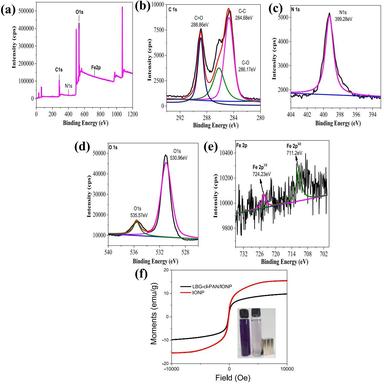
(a) An XPS spectrum of the composites with a wide scan; (b) XPS spectra of the C1s spectrum; (c) N1s spectrum; (d) O1s spectrum; and (e) Fe 2p spectrum of LBG-cl-PAN/IONP HNC. (f) LBG-cl-PAN-IONP measured by M-H hysteresis loop/vibrating sample magnetometer (VSM) at room temperature. The inserted figure shows the magnetic separation of the adsorbent with a handheld magnet after adsorption of MV dye in aqueous solution.